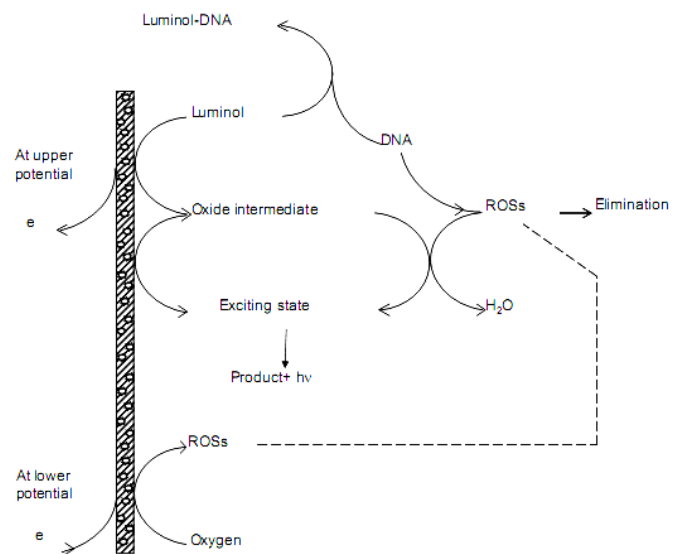
Scheme 1. The mechanism of the ECL response of luminol on proposed